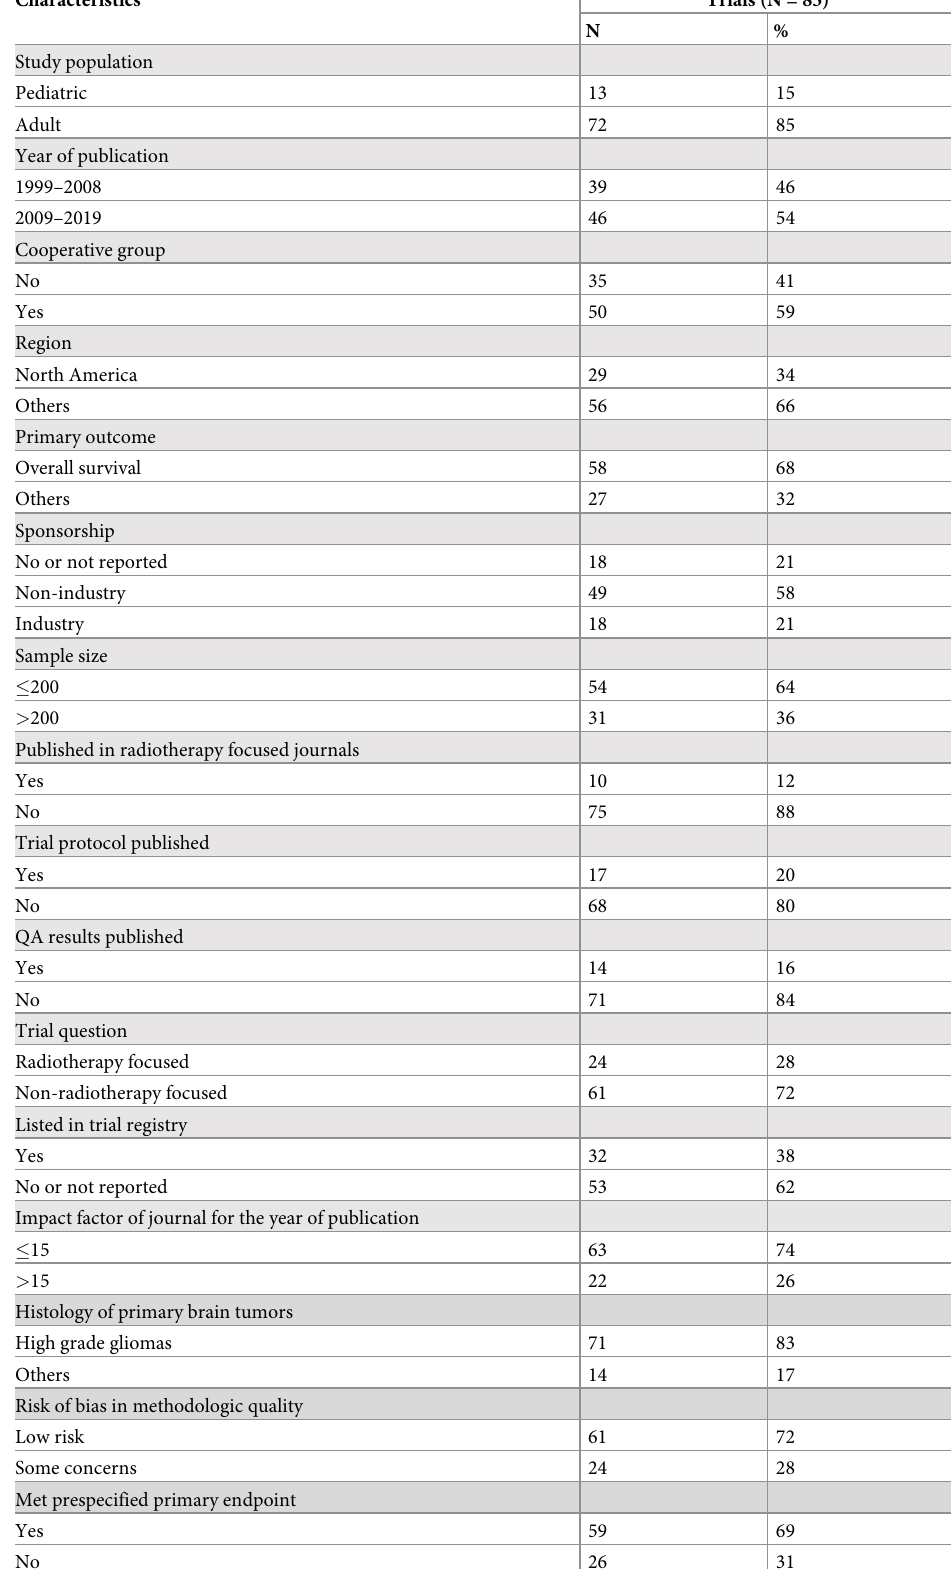
Table 2. Characteristics of included